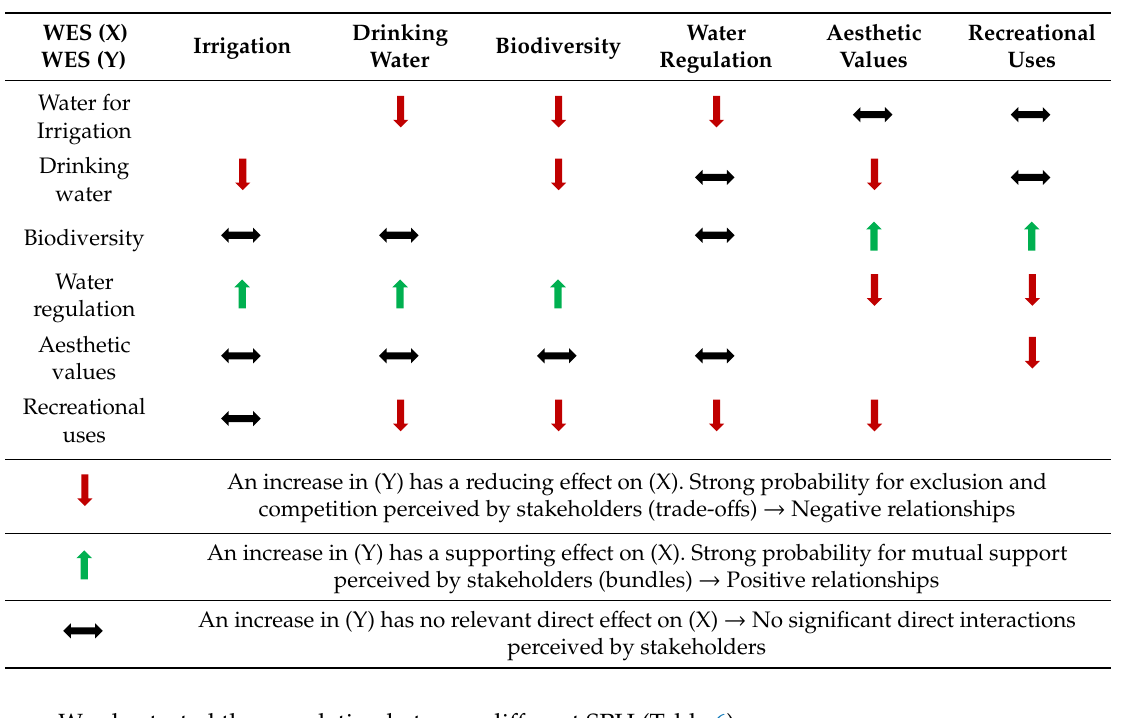
Table 5. Direct interactions between water ecosystem services (WES) in the Muga river basin as perceived by stakeholders.